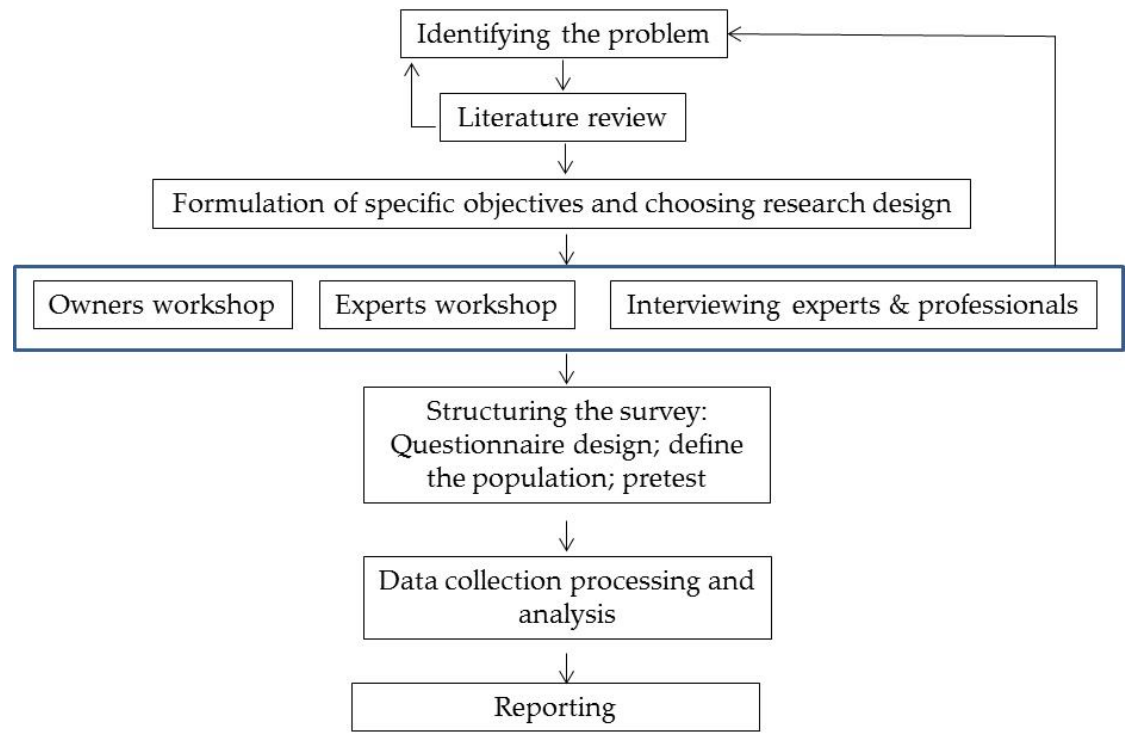
Figure 3. Block diagram research methodology .